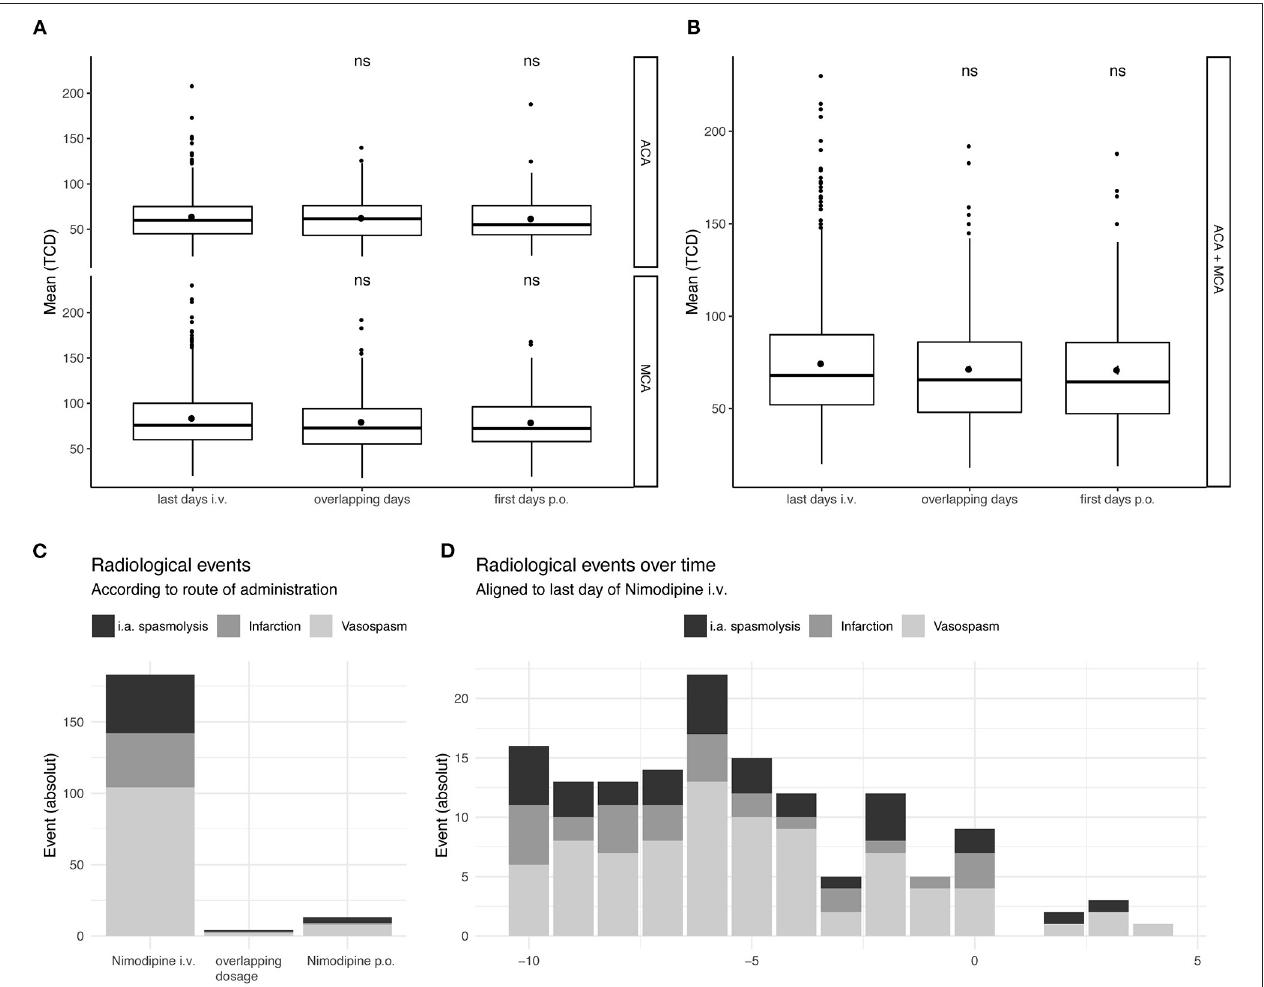
FIGURE 3 | Temporal resolution of complications in subgroups in relation to the timing of the switch. Taking all measured TCD values in account of all patients included in the study not only longitudinal but all values were considered. TCD values on the last 2 days of Nimodipine iv. and the first 2 days of oral administration only were depicted, together with overlapping dosages. (A) Values for A. cerebri anterior (upper) and A. cerebri media (lower) are depicted separately. (B) All TCD values independent of their circulation are depicted. The lower and upper hinges of the boxplots correspond to the first and third quartile of all values. The whiskers represent the 1.5 inter quantile range (IQR). Statistical analysis was performed with unpaired t -test compared to the last day of i.v. administration. (C) Absolute amount of the radiological events are show according to the administered drug. (D) Radiological events over all the ICU stay (Absolute numbers). ns, not